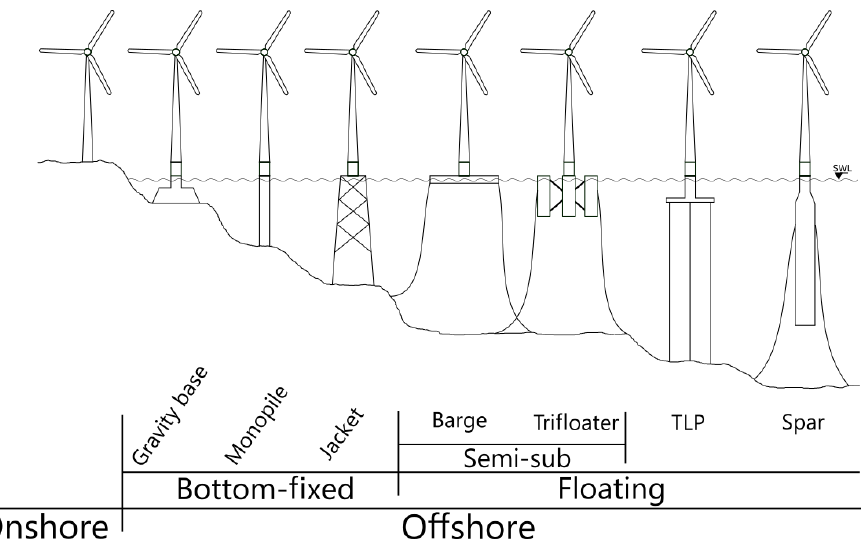
Figure 1. Illustrative representation of the main offshore wind turbine